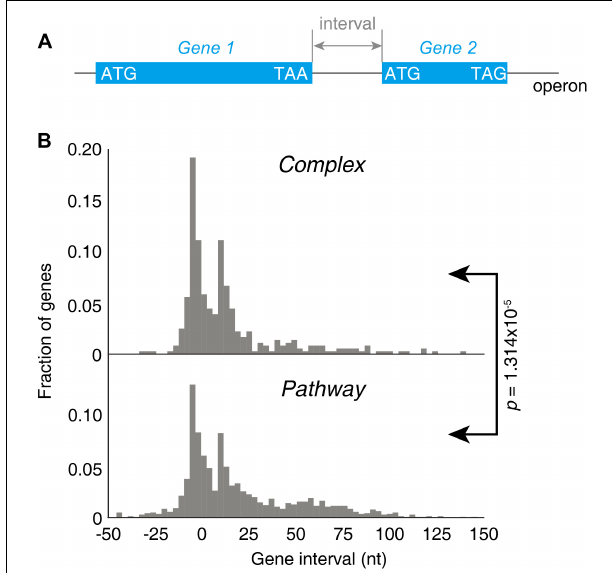
FIGURE 6 | Gene intervals in the “Complex” and “Pathway” operons. (A) Illustration of the gene interval within one operon. (B) Distribution of the gene intervals of “Complex” and “Pathway”